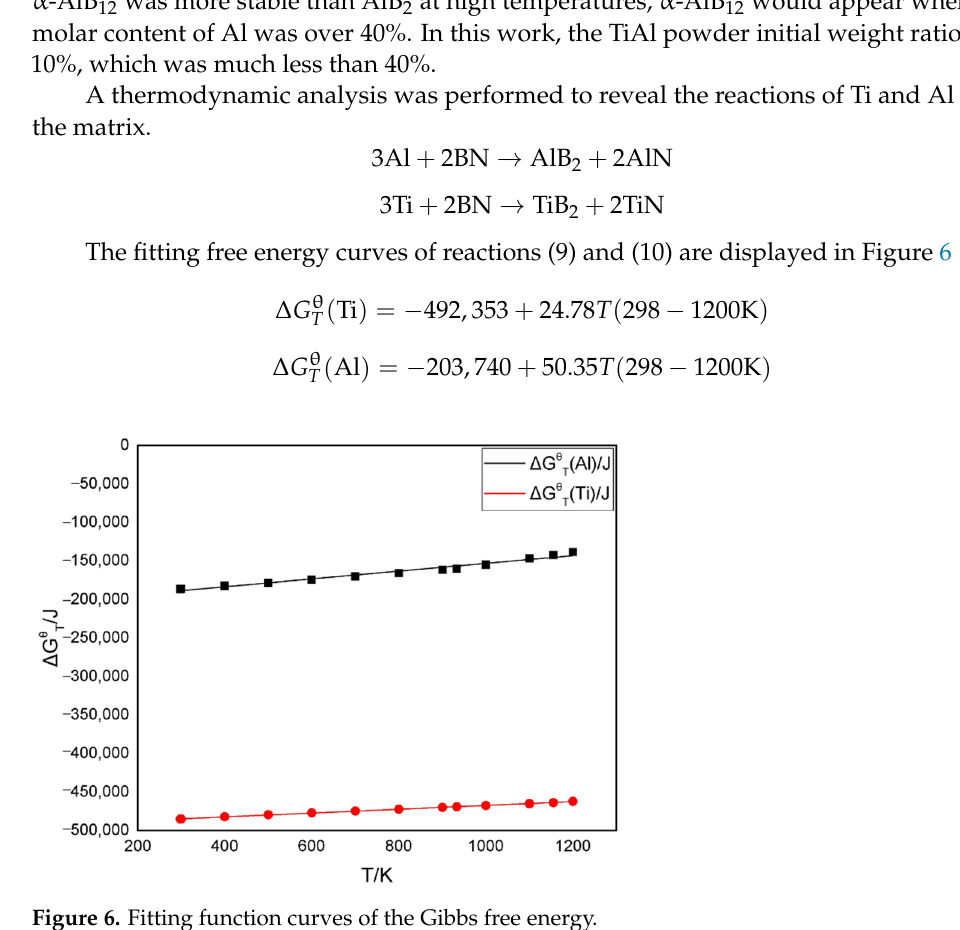
Figure 6. Fitting function curves of the Gibbs free energy.